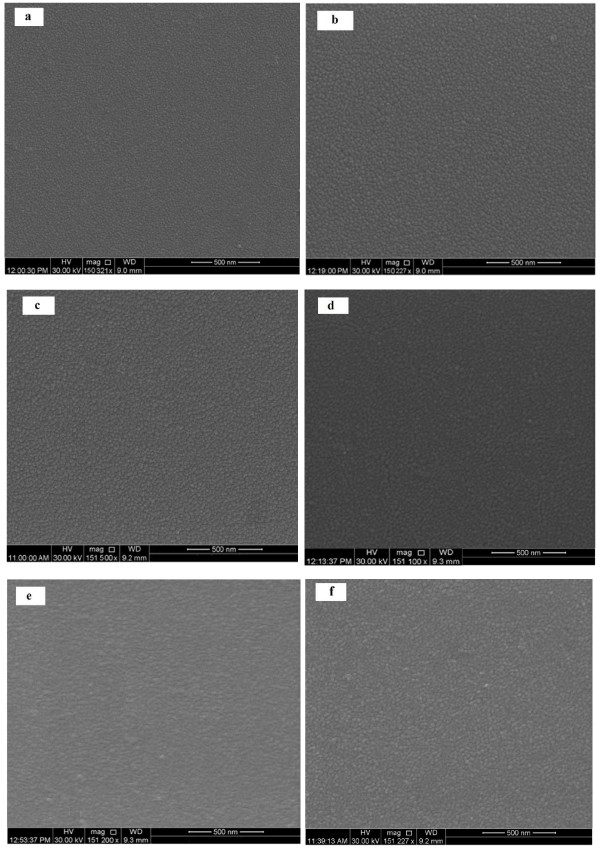
SEM images for the thin films of SexTe100 −xnanoparticles. (a) Te, (b) Se3Te97, (c) Se6Te94, (d) Se9Te91, (e) Se12Te88, and (f) Se24Te76.